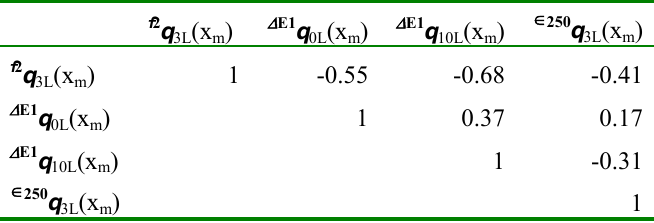
The squared correlation matrix showing covariance (r 2 ) among the macromolecular topological descriptors [local (nucleotide) nucleic acid quadratic indices] used in the regression analysis